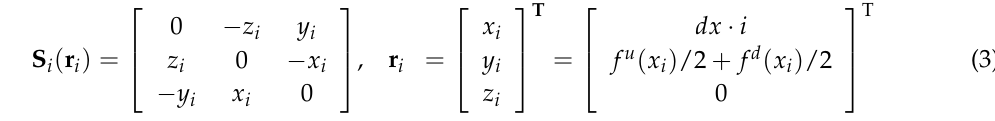
Figure 5. The influences of the PDCM’s decoupling angle Θ on the elliptical parameters and relative ratio. ( a ) Axial length a and b vs. decoupling angle Θ ; ( b ) Aspect ratio λ vs. decoupling angle Θ .